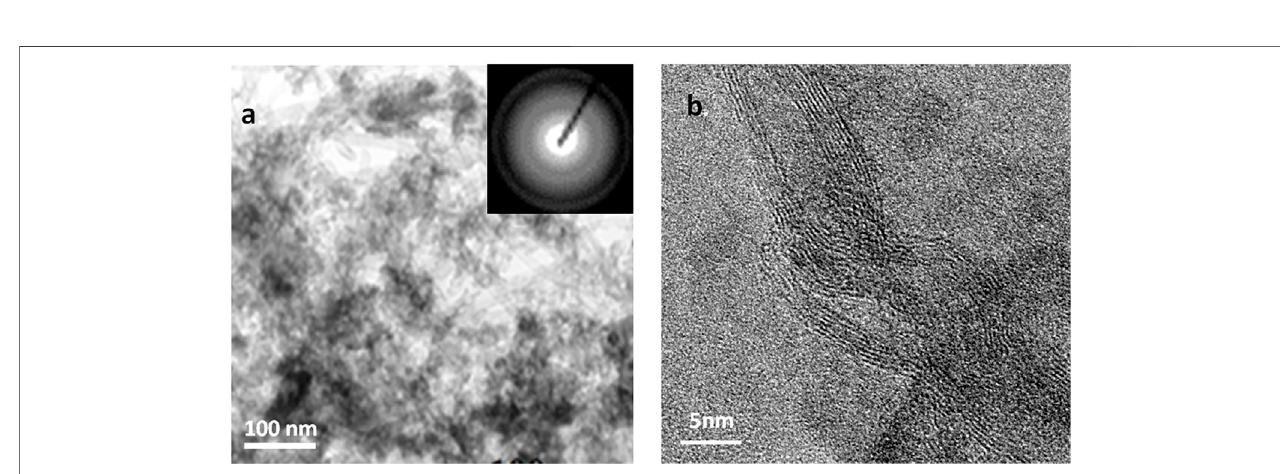
FIGURE 5 | TEMs of fCNT/TiO 2 .ZrO 2 (36)500 ° C.20: (A) general view showing Nps covering fCNTs; inset: electron diffraction pattern indicating the amorphous character of the Nps; (B) HRTEM showing Nps on fCNT walls.